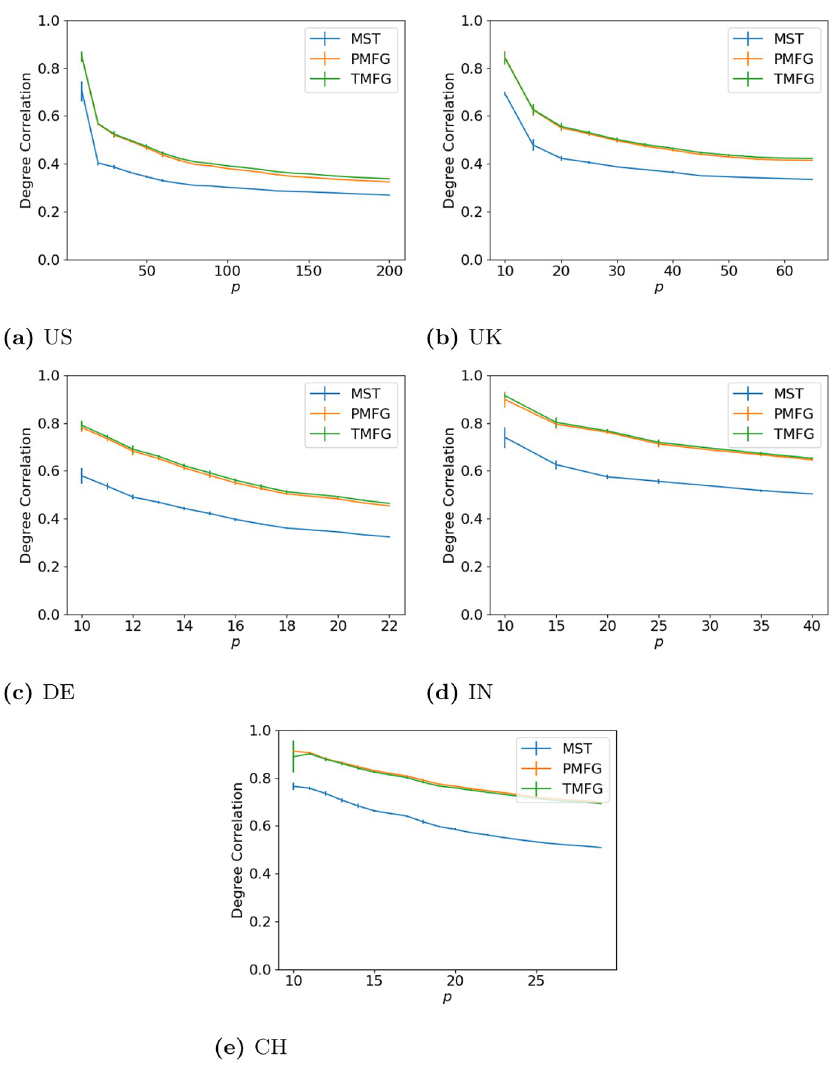
Fig 4. Degree agreement between the full and filtered correlation matrices with different values of p for the windows with median volatility. ( a ) US, ( b ) UK, ( c ) DE, ( d ) IN, ( e )